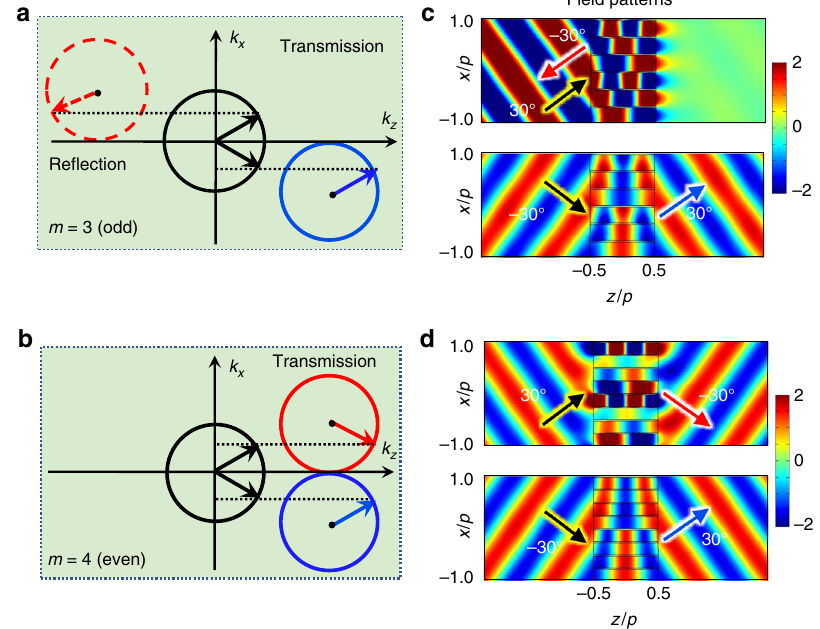
Fig. 2 Parity-dependent phenomena. a , b The equifrequency contours of the PGMs ( ξ = k 0 ) with odd unit cells and even unit cells, respectively, where the black circles are the equifrequency contours of incident wave in air, the blue circles are the transmission contours of the n = 1 order and the solid (dashed) red circle is the transmission (re fl ection) contour of the n = − 1 order. c , d The simulated acoustic total fi eld patterns of the PGMs ( ξ = k 0 ) with three cells and four unit cells, respectively. In each case, the upper (lower) plot is the case of θ in = 30° ( θ in = − 30°). All the arrows represent propagation directions. In simulations, p = h = λ 0 , a = 0.9 w and n j = ρ